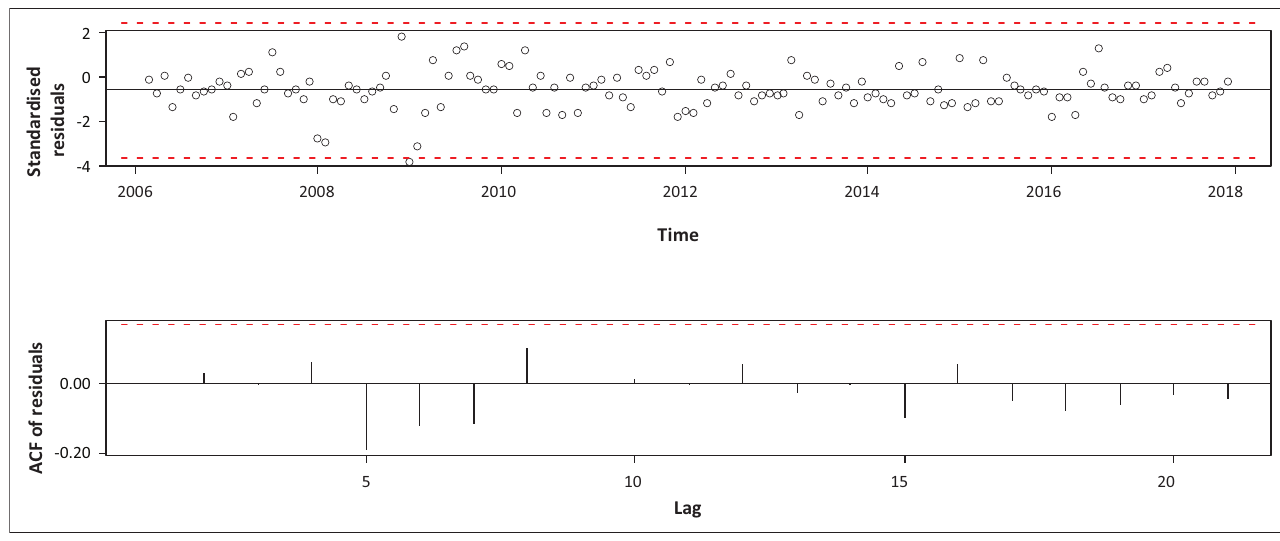
FIGURE 1: Diagnostic display for the SARIMA(2,1,0)(2,0,0)